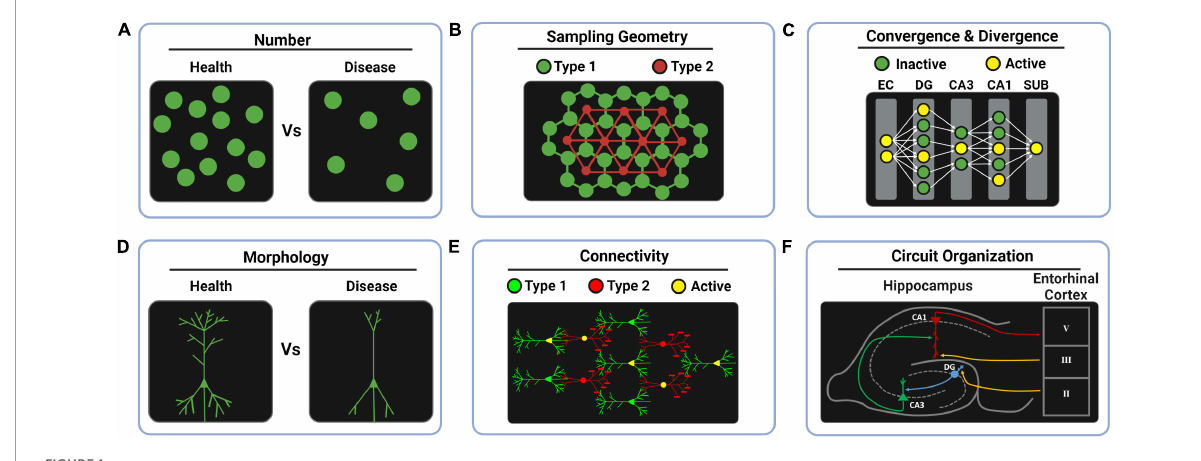
FIGURE1 Whole-brain anatomical features for computational neuroscience. (A) The computational redundancy of the brain can be studied by cell counting in health and disease to predict the minimal percentage of neuronal loss that leads to symptoms. (B) Studying the sampling patterns that the brain uses for covering the space can reveal different design principles across brain regions such as the regular mosaic principle found in tagged functional cell types of the retina. In the drawings, lines between cells represent spatial distances, not real connections. (C) Encoding transformations can be interrogated by studying increments (divergence) or decrements (convergence) in neuron number across layers. Likewise, sparse coding and dense coding strategies might be revealed by tagging the percentage of active neurons in each layer during behavioral tasks. (D) The computational impact of morphological features can be studied by comparing health and disease models. (E) Data-driven morpho-neuronal models can be elaborated to understand the design principles behind structural connectivity. (F) Genetically labeling functional cell types provides a way to ultimately study the fine circuit organization of complex brain regions. EC, entorhinal cortex; DG, dentate gyrus; CA3, Ammon’s horn field 3; CA1, Ammon’s horn field 1; SUB,